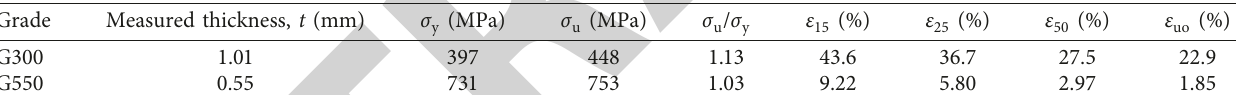
Table 4: Measured yield stresses of G550 and G300 steel sheets.